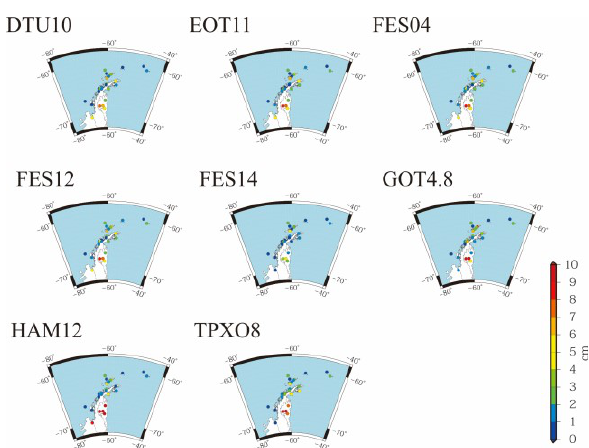
Figure 6. Magnitudes of vector differences between observed and bilinearly interpolated M 2 signals for Antarctic Peninsula region. The spatial patterns of different models are similar, the large vector differences are in the eastern part of Antarctic Peninsula, and their latitudes are always higher than others, especially the Larsen C Ice